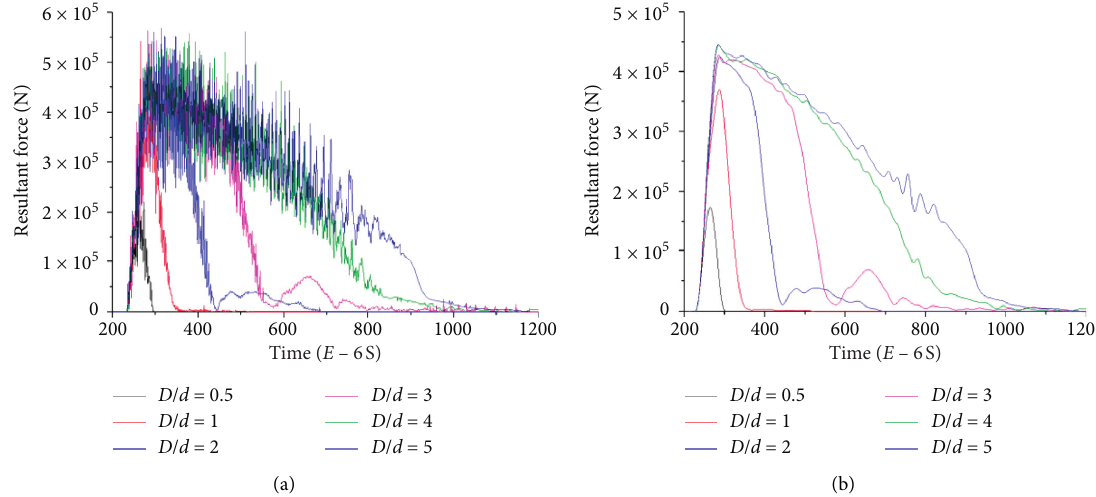
Figure 8: Contact force-time curves of stones of different sizes. (a) Contact force-time curves of stones. (b) Polished contact force-time curves of stones.